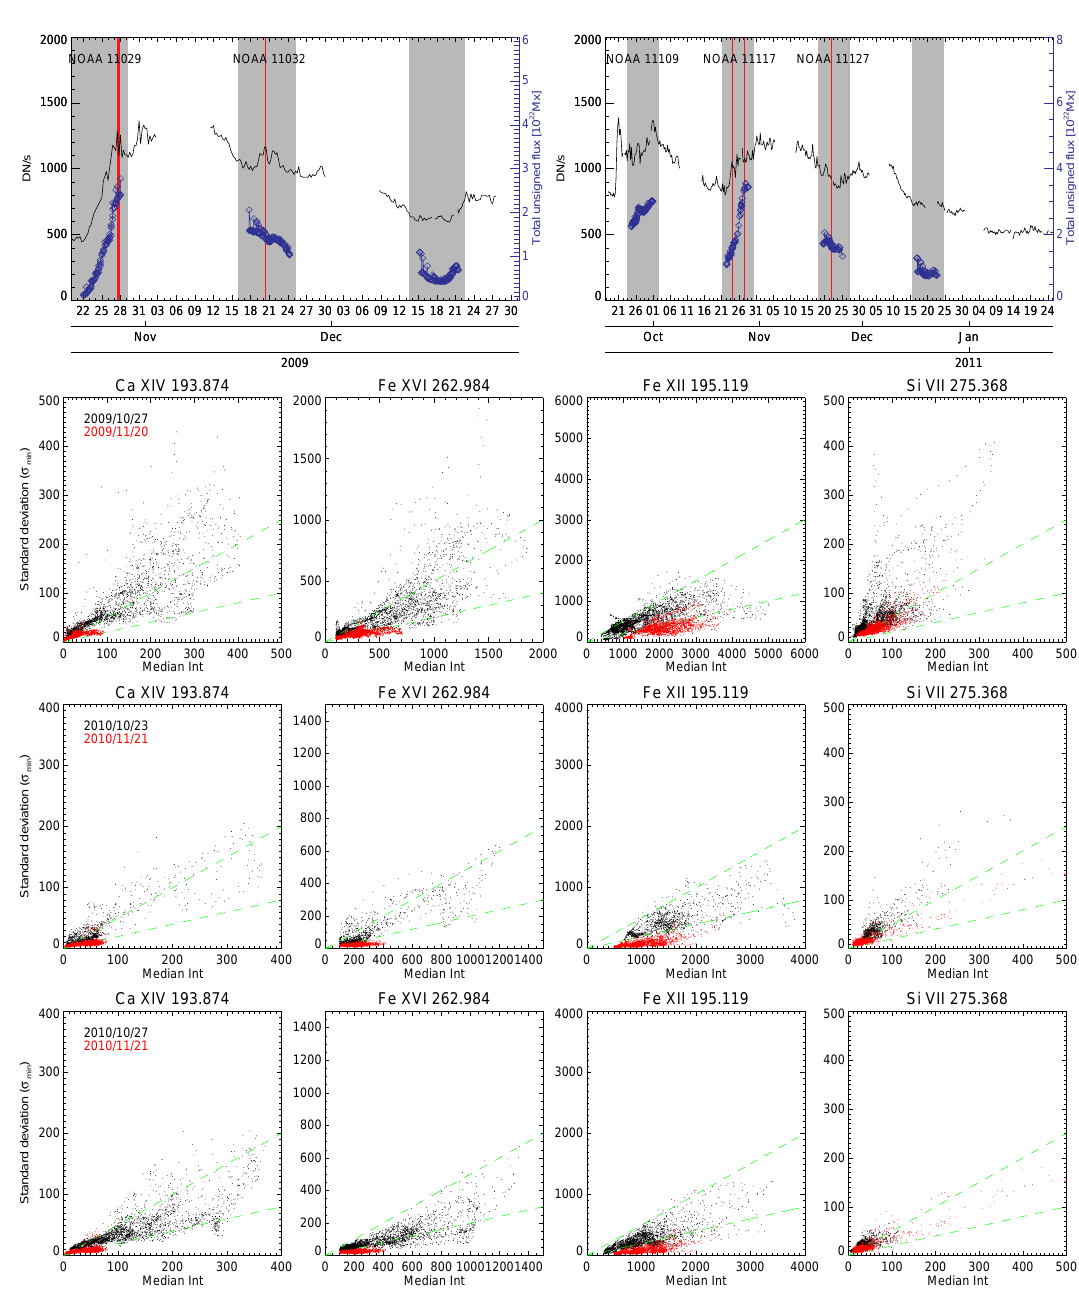
Figure2. Activeregion11029asseeninitsfirst(top)andsecond(bottom)Earthviewpasses.Fromlefttoright:MDI / SOHO magnetogram,EIT / SOHO 195Åimage and EIS / Hinode scans. See AR lifetime context in Figure 1. (A color version of this figure is available in the online journal.) emission measure increase that coincides with the emergence, followed by a slow decay while the magnetic flux diffuses and fades into the background quiet Sun field. The link between Figure 25: Top panel: Flux emitted in the 304 ˚A passband (SOHO/EIT and SDO/AIA data) during these trends and the properties of the apparently different loop the multiple on-disc passages of the two ARs analysed is shown in black, with the relevant NOAA AR populations has not been determined yet. This is the main focus numbers indicated. The MDI total unsigned flux is plotted with blue diamonds below the flux curve. of this investigation. Hinode /EIS observing intervals are indicated by red vertical lines. Grey areas indicate intervals when the AR analysed was within – 60 (cid:176) of the central meridian. Bottom panels: Variability of core pixels during the growth(black) and decay (red) phases of two ARs (top: AR 11029; middle and bottom: AR 11117). Dashed green lines indicate the 50% and 20% levels. Images reproduced with permission from Ugarte-Urra and Warren (2012), copyright by